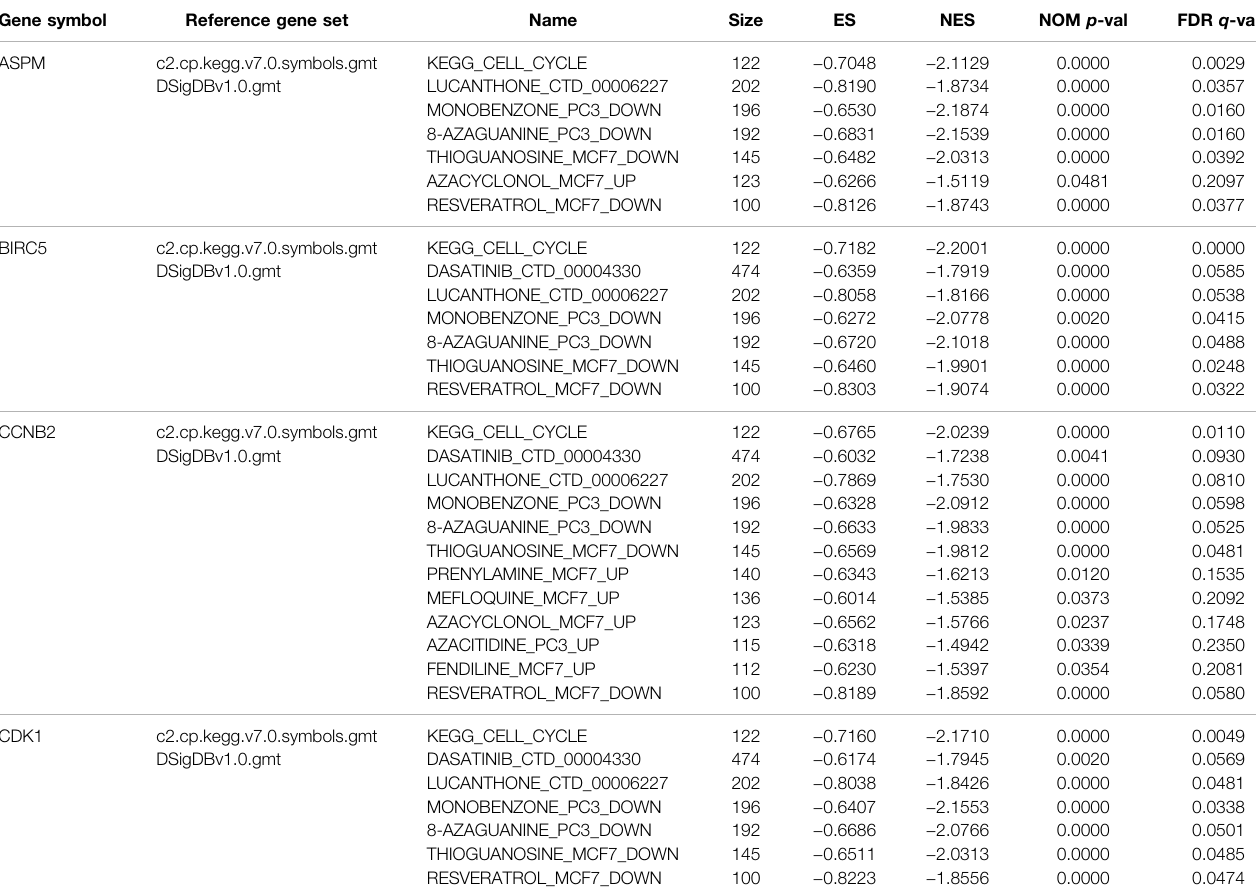
TABLE 3 | Gene set enrichment analyses in four hub genes ’ (ASPM, BIRC5, CCNB2, CDK1) high-expression phenotype. Gene